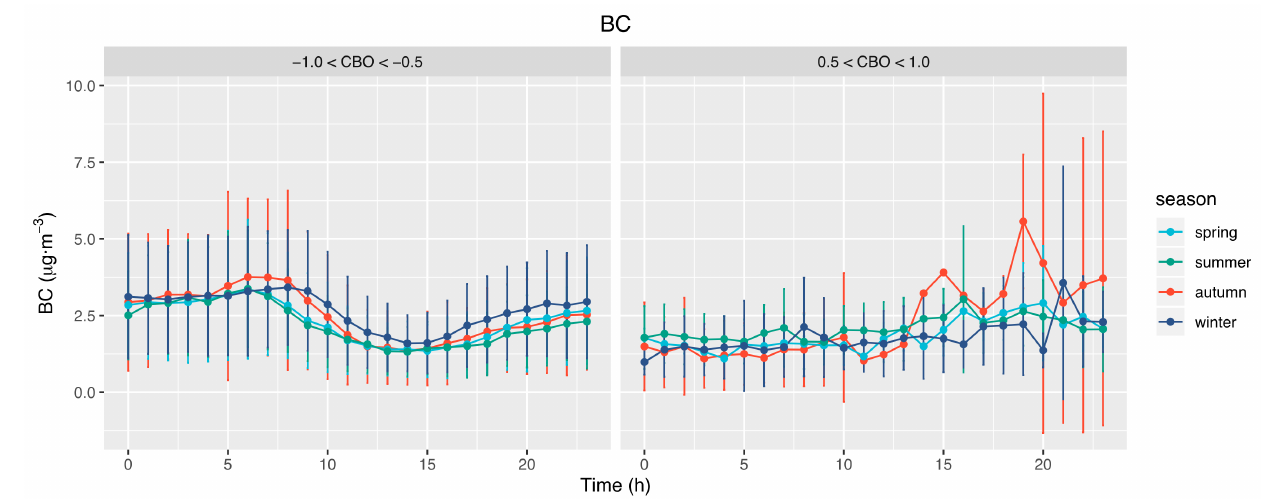
Figure 6. Diurnal variations of BC in two situations: ( left ): − 1.0 < CBO < − 0.5 and ( right ): 0.5 < CBO < 1.0.